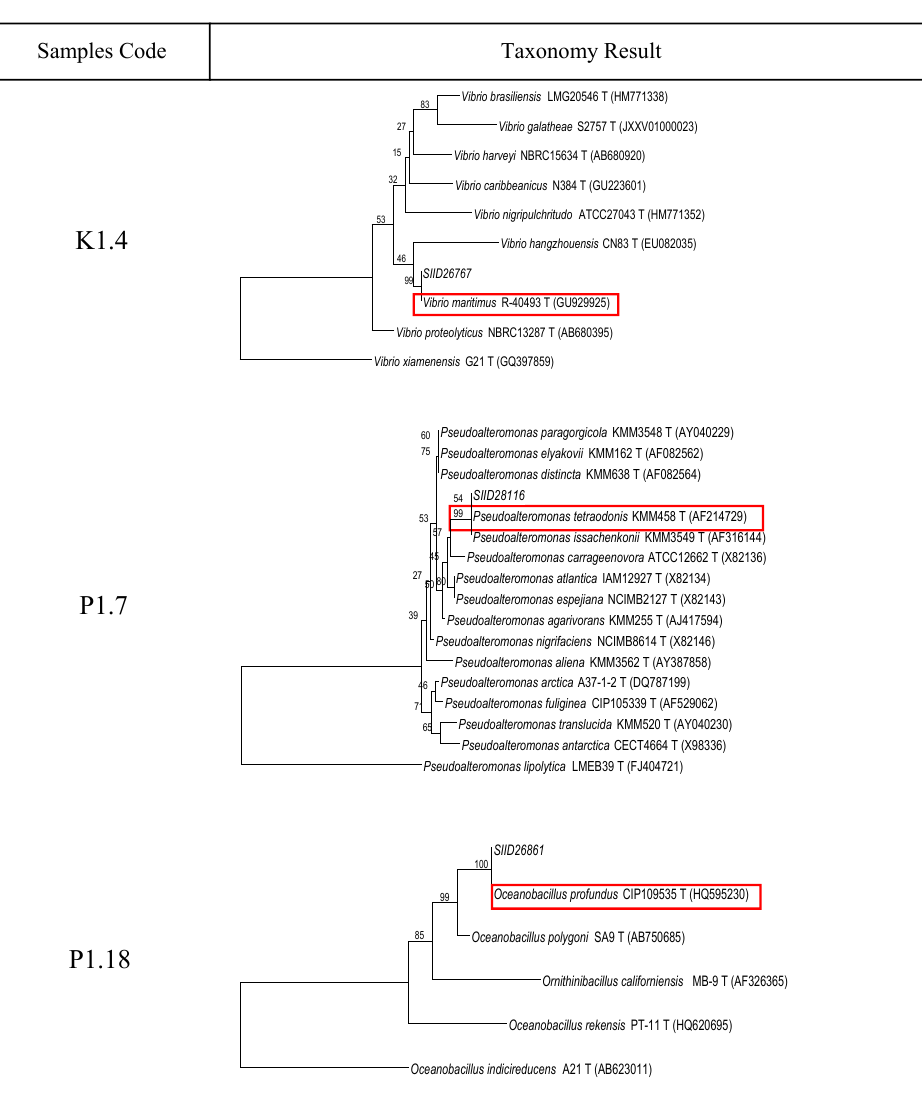
Figure 4. Figure 4. Phylogenetic trees result of 16S rDNA nucleotide sequence of local bacteria taxonomy (red- frame).